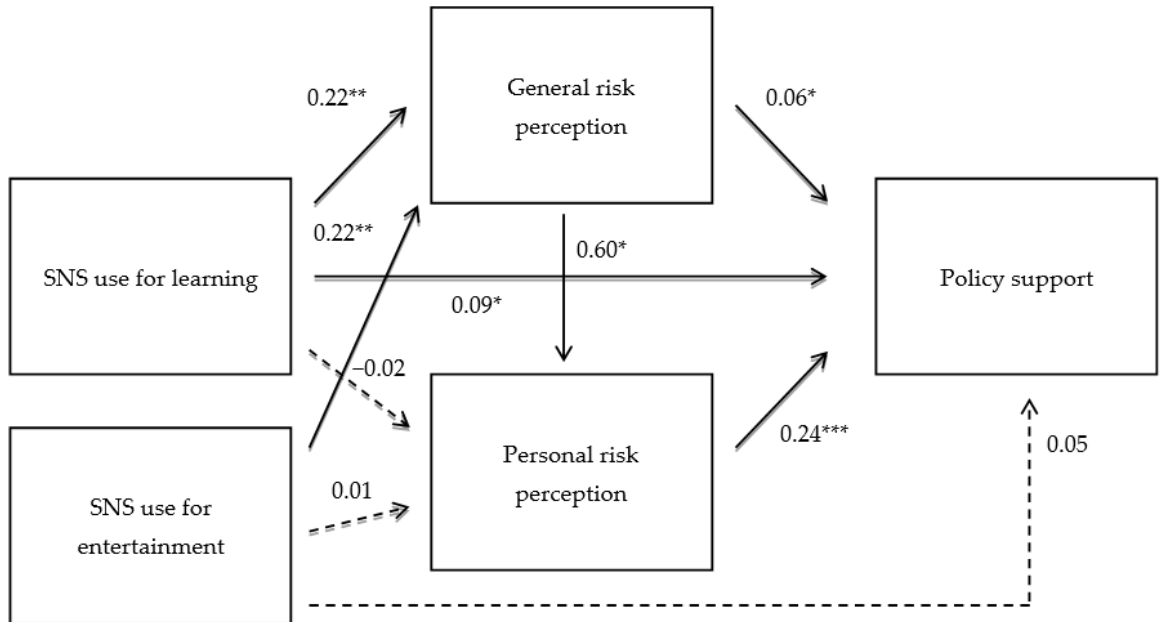
Figure 2. Results of hypothesized model of the study. Note. All the coefficients are standardized. Dotted lines represent insignificant results. * p < 0.05, ** p < 0.01, *** p < 0.001.